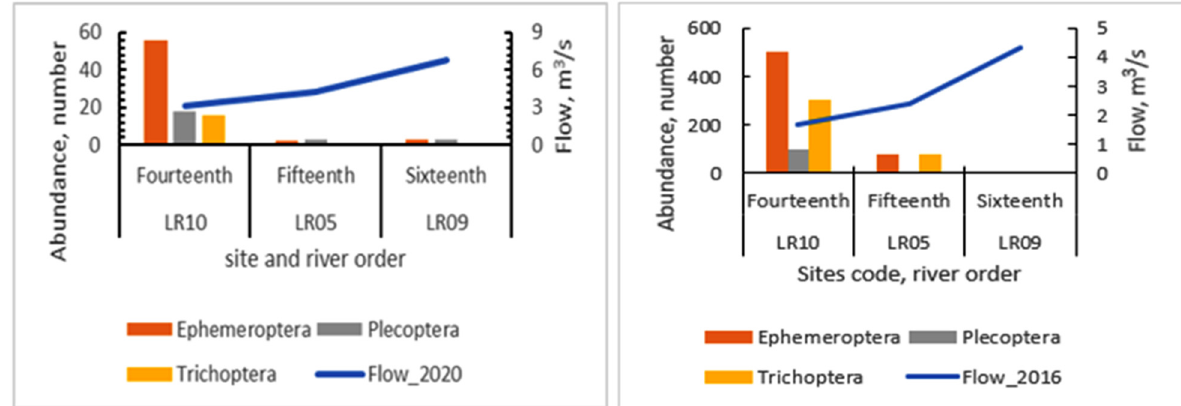
Figure 9. Ephemeroptera, Plecoptera, and Trichoptera (EPT) and flow of different river orders in the lower reach of Gumara in March 2016 and March 2020. LR—lower reach, MR—middle reach, and UR—upper reach.